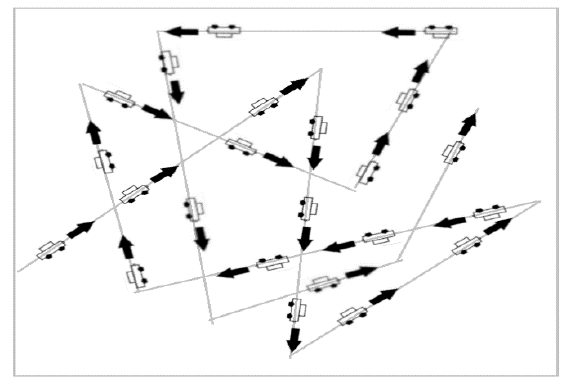
Figure 4. An Example of a Random Waypoint Mobility Model